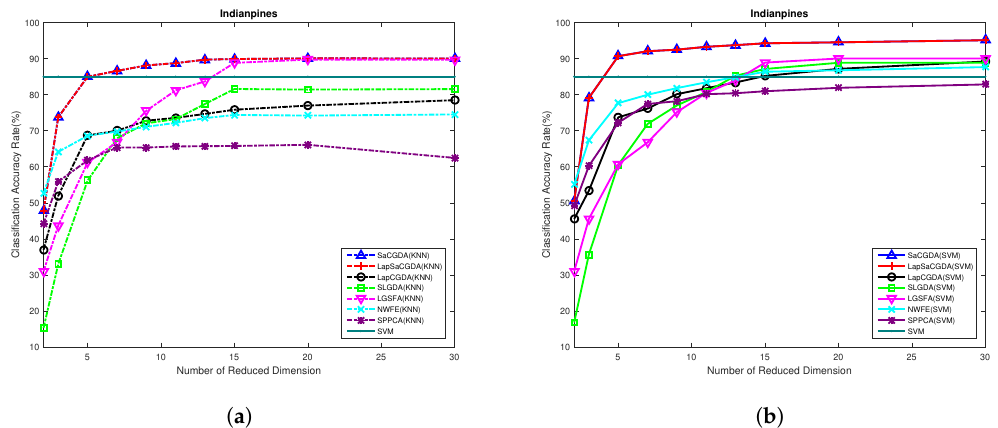
Figure 11. Classification accuracy w.r.t. different dimensionality of the projection space on the Indian Pines data: ( a ) OAs based on KNN; ( b ) OAs based on SVM.